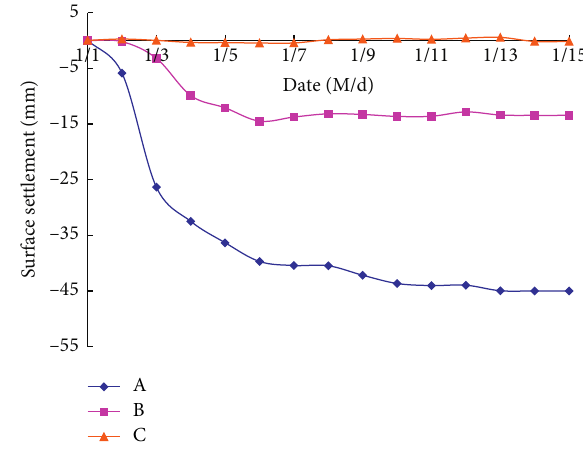
Figure 11: Settlement curves of the embankment